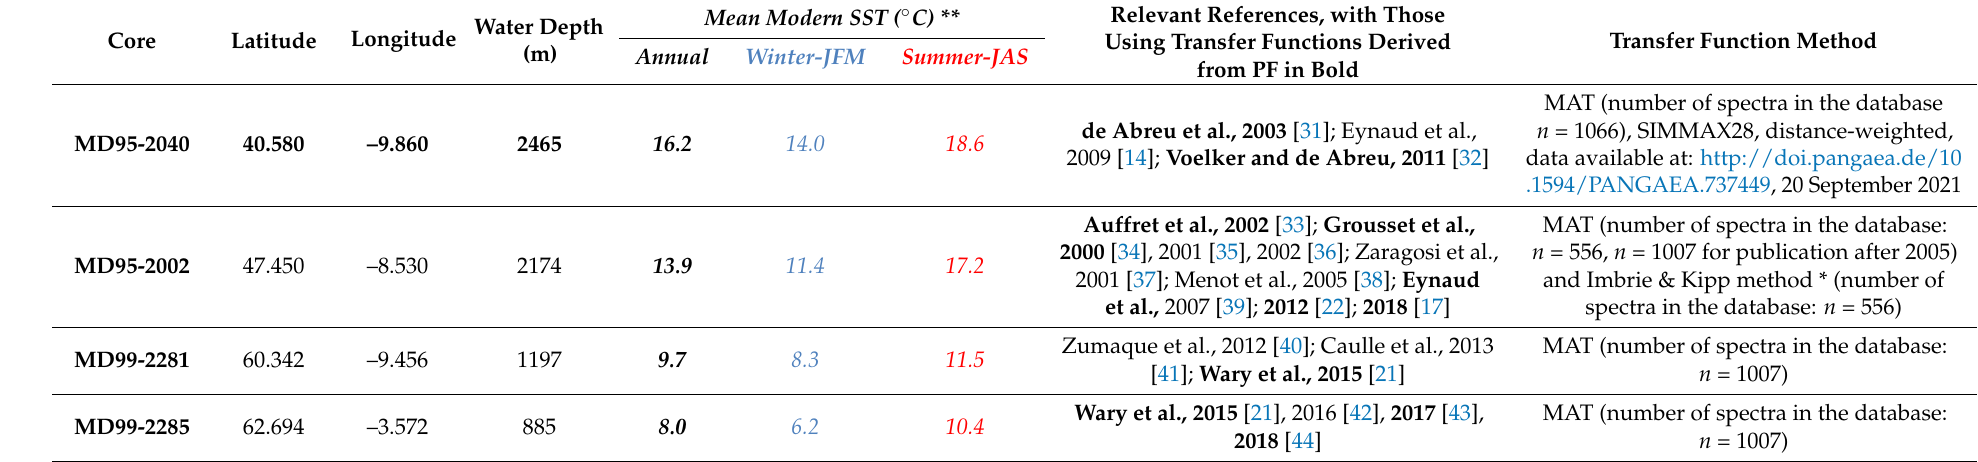
Table 1. Information on the investigated cores (MD95-2040, MD95-2002, MD99-2281 and